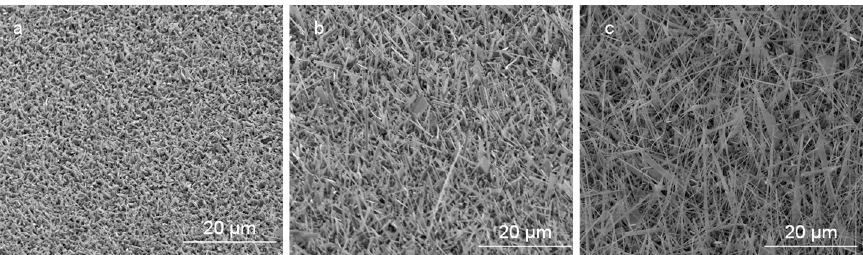
Figure 4. SEM images of uncoated and Ag-coated areas acquired in the regions indicated in the illustration. ( a ) nanocrystalline thin film of Ga 2 O 3 obtained by the indirect effect of the sample patterned by Ag catalyst within the uncoated area. ( b ) Ga 2 O 3 NWs under the presence of 5 nm Ag. ( c ) Ga 2 O 3 NWs under the presence of 300 nm Ag.